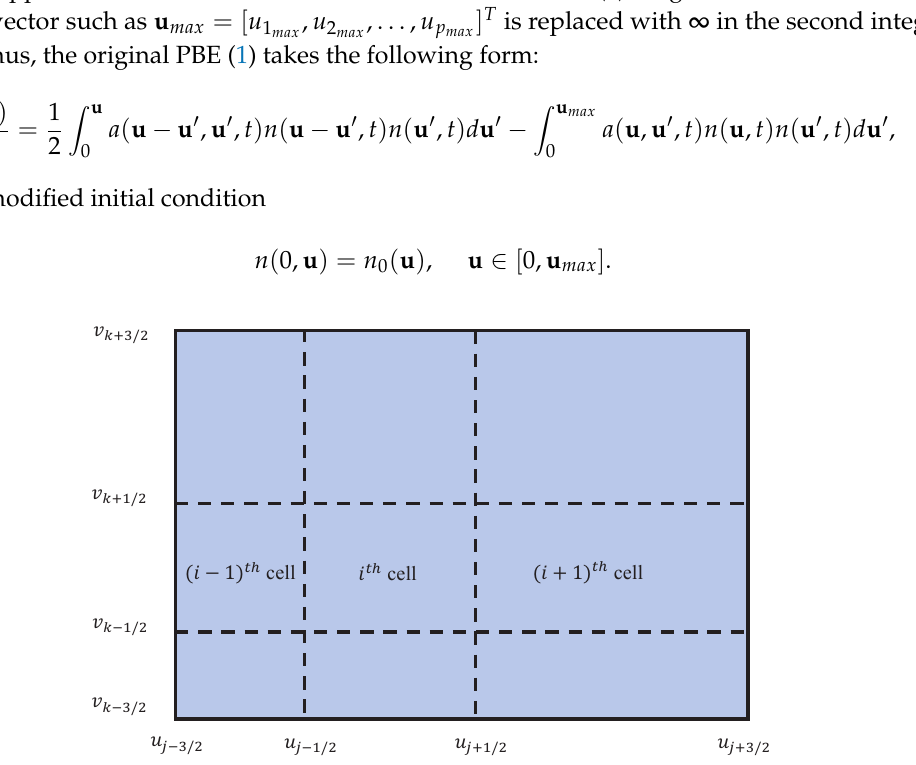
Figure 1. Rectangular domian discretization in 2D